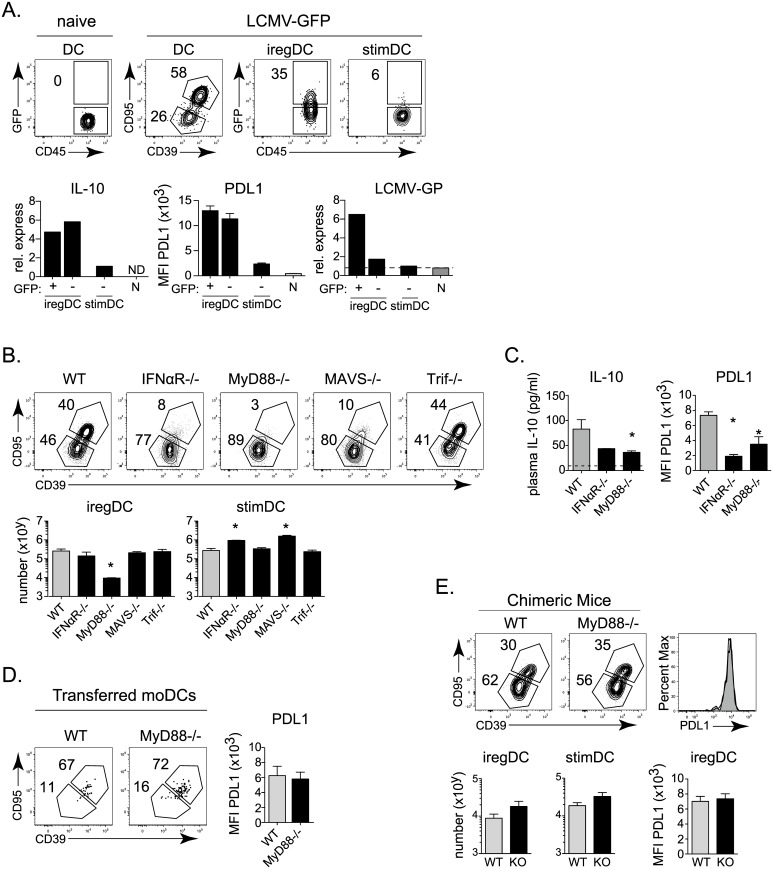
iregDC extrinsic MyD88 signaling, but not direct LCMV infection or IFNβ signaling is required for iregDC differentiation.
A. WT mice were CD8 depleted and then infected with LCMV-Cl13-GFP. Flow plots show GFP expression (i.e., LCMV infection) in splenic iregDC and stimDC (gated on CD39 and CD95) on day 9 after infection. In parallel, naïve splenic DC (N), and iregDC and stimDC were FACSorted based on GFP expression on day 9 after infection. The level of GFP+ stimDC was too small to obtain adequate numbers for RNA isolation. Bar graphs show relative expression of IL-10 RNA, LCMV-GP RNA and the MFI of PDL1 protein expression from the sorted populations. To obtain sufficient cell numbers for the RNA analyses, infected and uninfected iregDC and stimDC were sorted from a pool of 8 mice. Data show one of two experiments. B. Flow plots show the percent and bar graphs the number of iregDC and stimDC in the indicated mouse strain from CD11b+ DCs at day 9 after LCMV-Cl13 infection. C. Bar graphs indicate plasma IL-10 concentration and PDL1 expression in WT, IFNαR-/-, and MyD88-/- mice at day 9 after LCMV-Cl13 infection. D. Naïve WT and MyD88-/- monocytes were transferred into WT mice and analyzed on day 9 after LCMV-Cl13 infection as described in Fig 4E. E. Mixed chimera mice were generated using bone marrow from WT and MyD88-/- bone marrow. Flow plots depict WT and MyD88-/- lineage splenic CD11b+ DCs at day 9 after LCMV-Cl13 of WT. Histogram shows PDL1 expression on iregDCs from WT (white) and MyD88-/- (grey) lineage cells. Bar graphs indicate PDL1 expression and the number of iregDC and stimDC from each lineage in the chimera mice. Data are representative of 2 or more independent experiments each consisting of 3–5 mice per group. *, p<0.05.